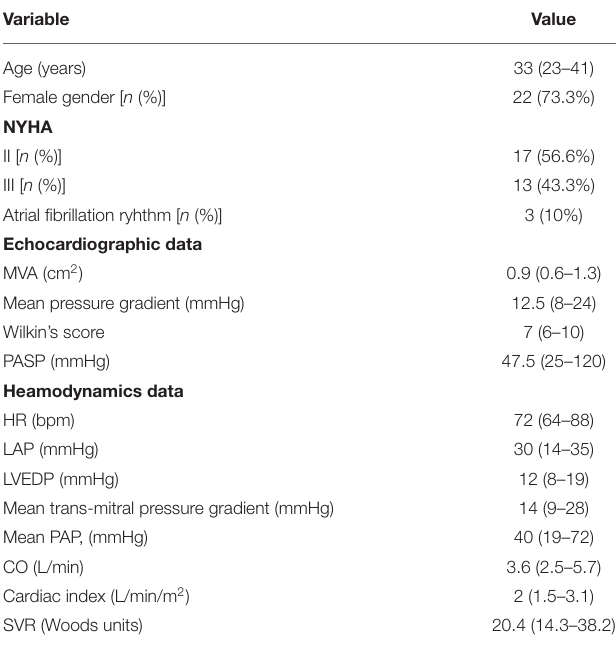
TABLE 1 | Baseline clinical, echocardiographic, and hemodynamic data of the patients. Variable